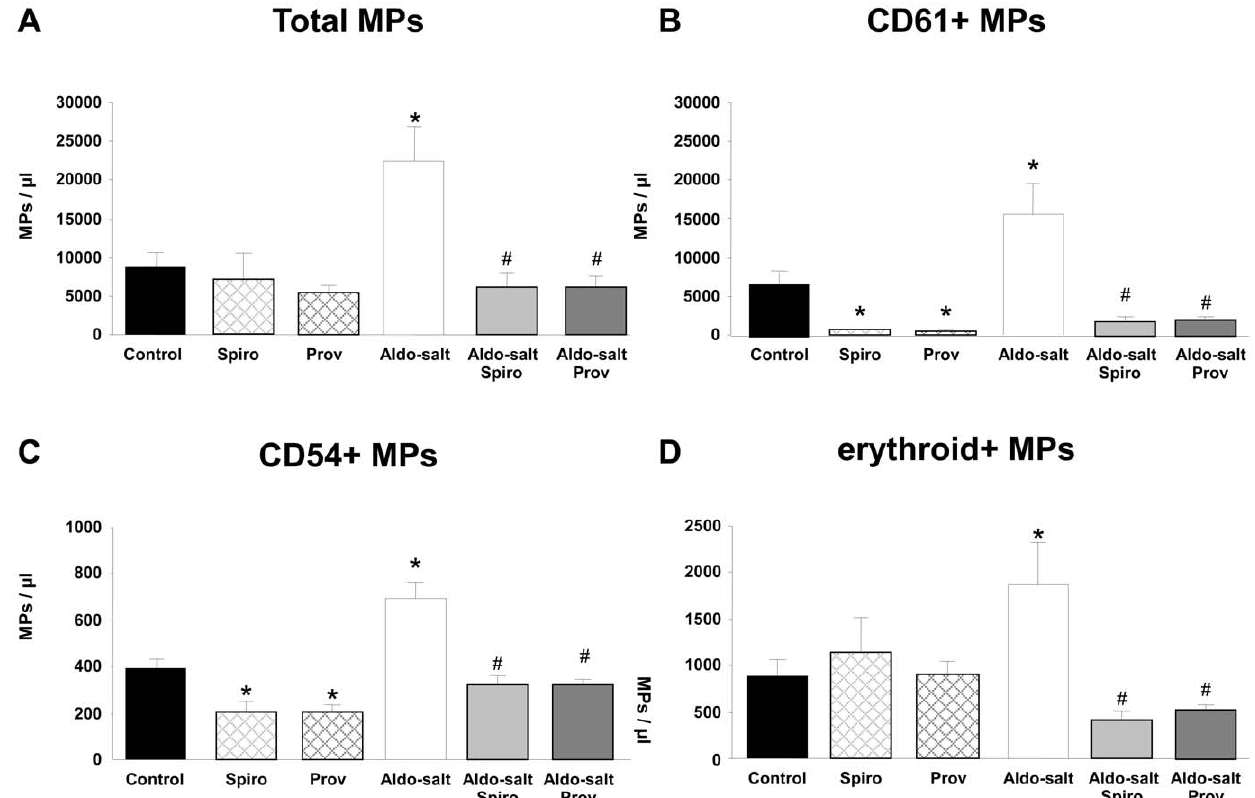
Figure 1. Circulating microparticles (MPs). Total MPs (A), platelet (CD61 + )- (B), endothelial (CD54 + )- (C) and erythrocyte- (D) derived MPs from control, spironolactone (Spiro), Provinols TM (Prov), aldosterone-salt (Aldo-salt), Aldo-salt Spiro and Aldo-salt Prov (n=4–5 for each group). Values are means 6 SEM, * P , 0.05 vs control rats. # P , 0.05 ## P , 0.01 vs Aldo-salt rats.